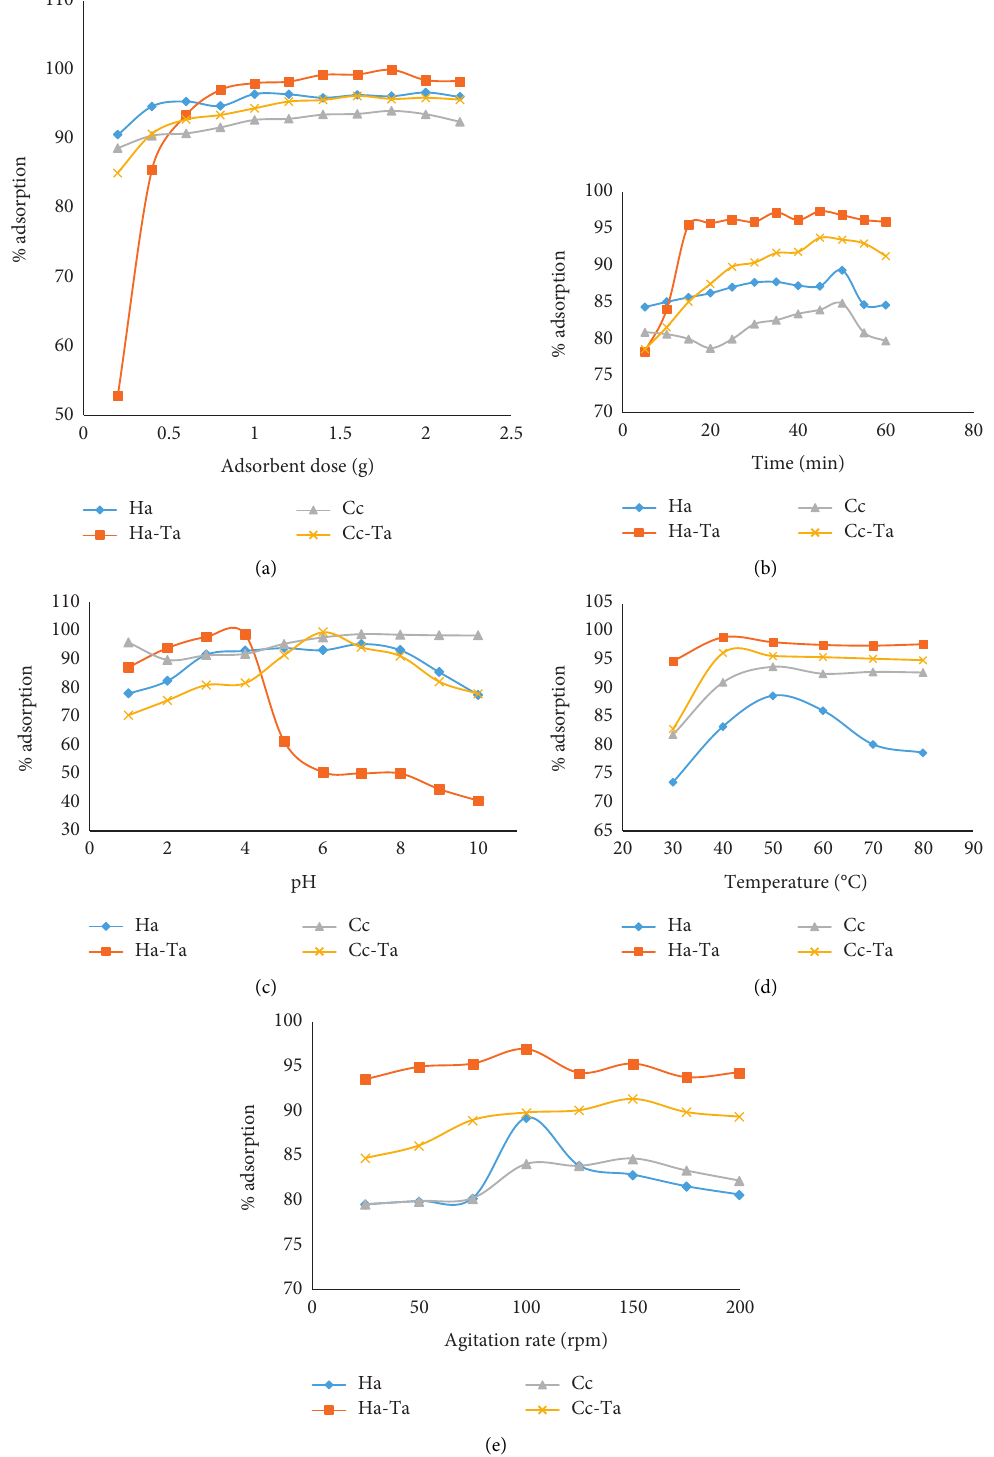
Figure 4: (a) Adsorbent dose, (b) time effects, (c) pH studies, (d) temperature effects, and (e) agitation rates for BG